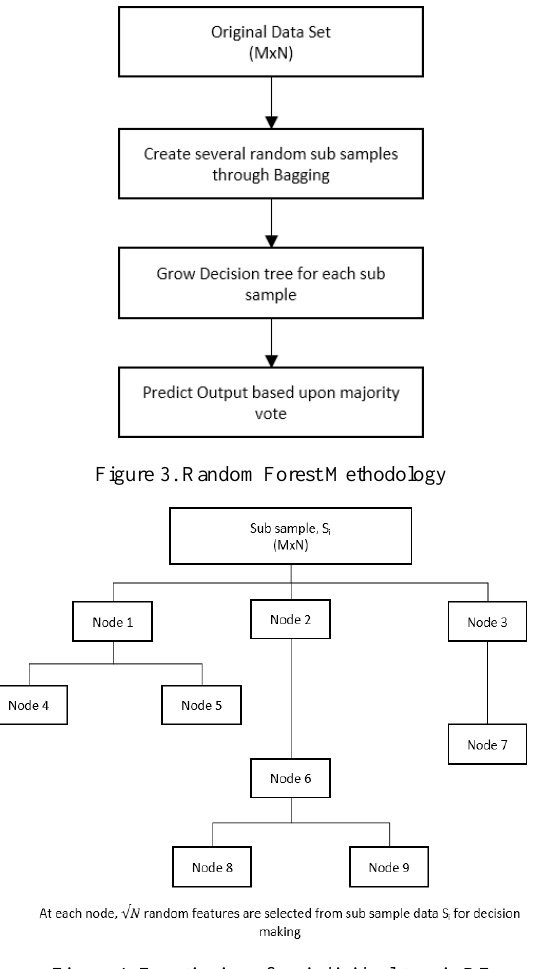
Figure 4. Functioning of an individual tree in